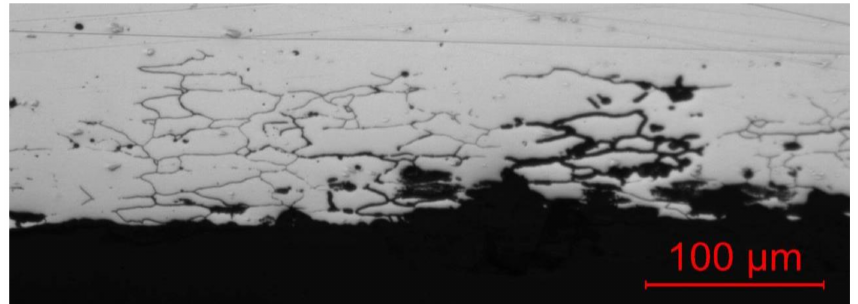
Figure 2. Intergranular corrosion observed on AA 2024 T351.